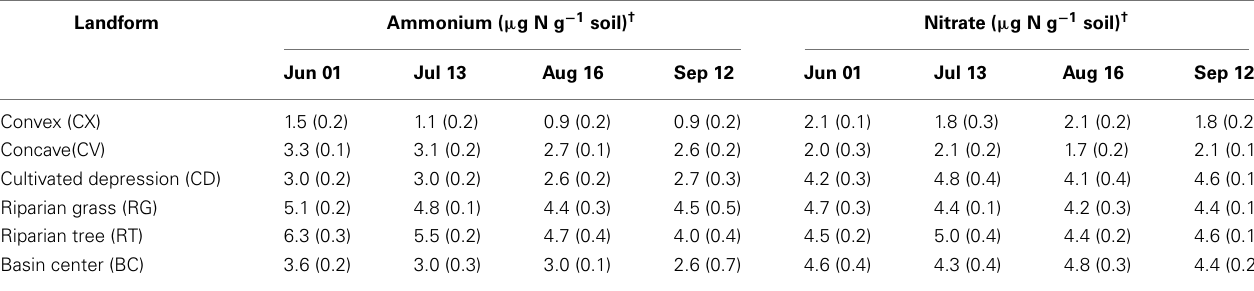
Table 3 | Two molar KCl extractable ammonium and nitrate concentrations in soils from each landform class in the St. Denis NationalWildlife Area collected June 1st–September 12th,